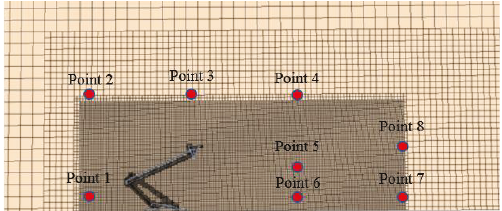
Figure 15: Observation points of improved